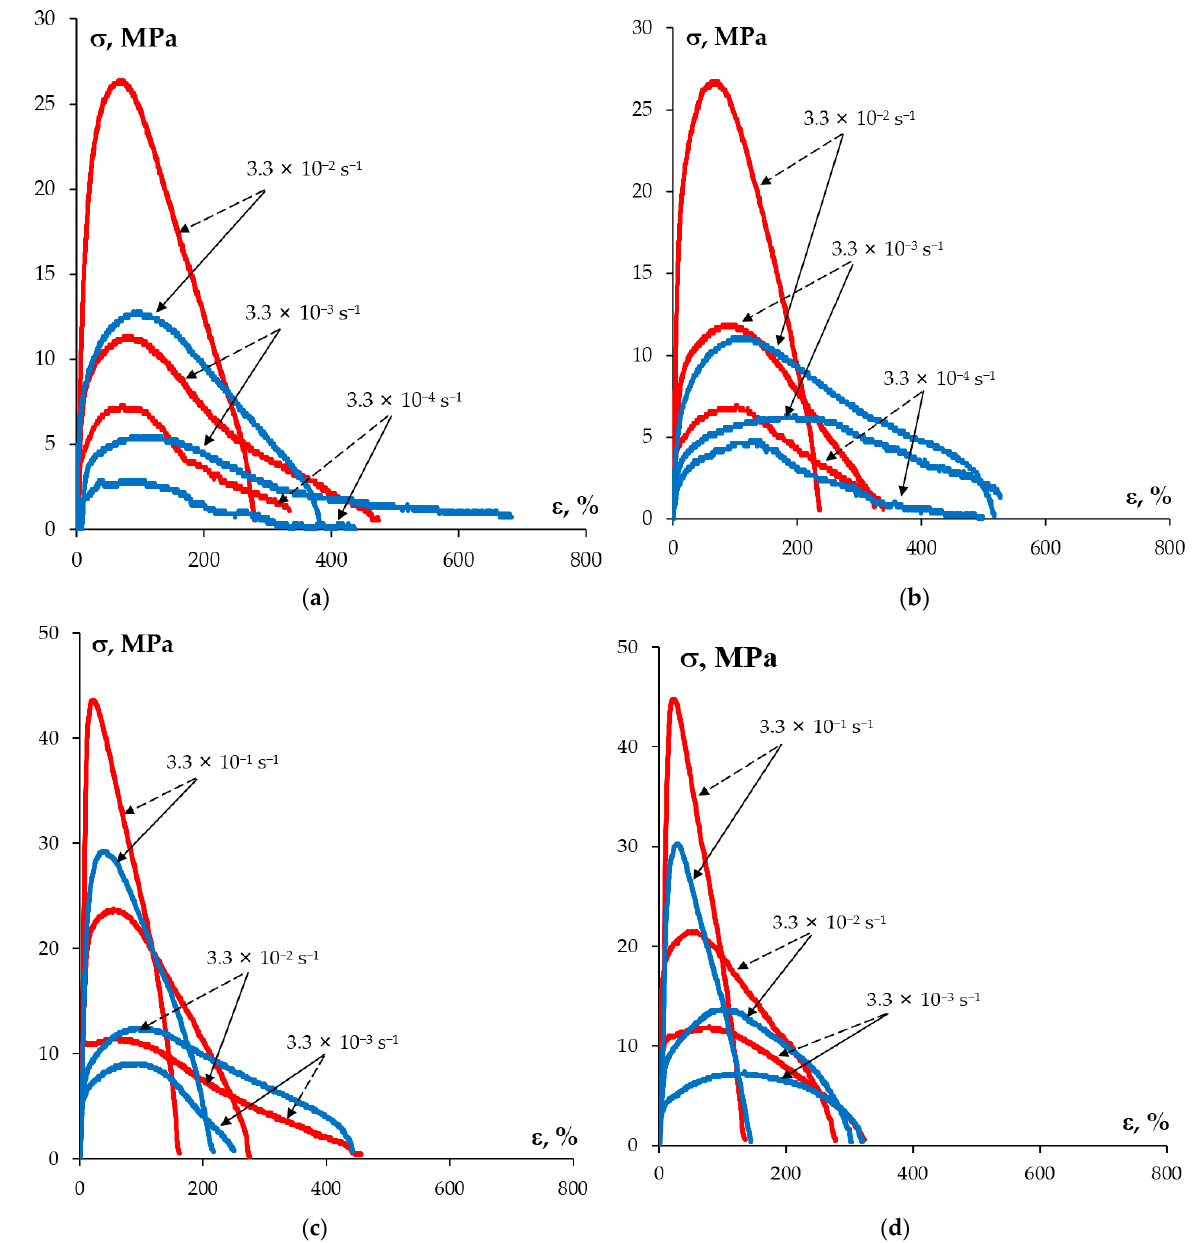
Figure 7. The effect of strain rate on σ ( ε ) curves in UFG alloy Nos. 2 ( a ), 5 ( b ), 7 ( c ), and 8 ( d ). Numbers near σ ( ε ) curves indicate strain rates at 500 °C.